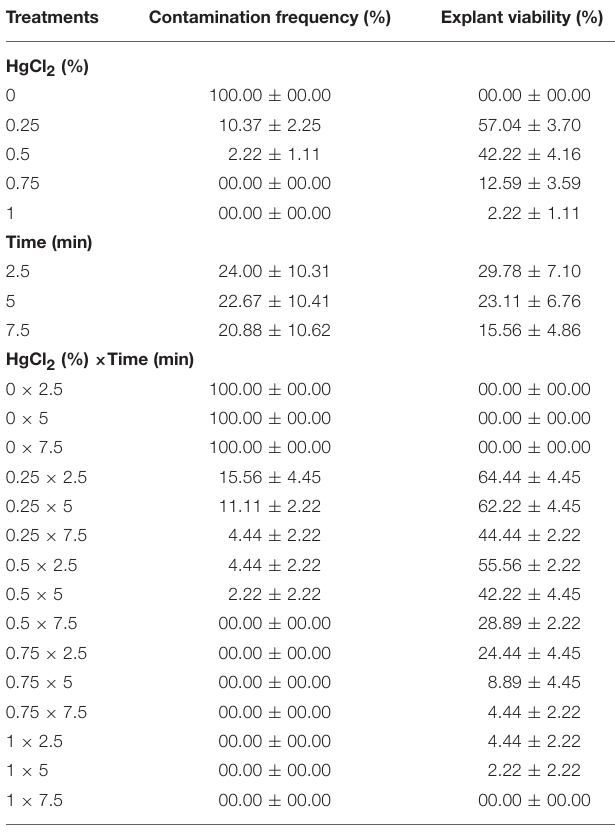
TABLE 2 | Effect of different concentrations of Ca(ClO) 2 at various immersion times on in vitro sterilization of chrysanthemum. Treatments Contamination frequency (%)